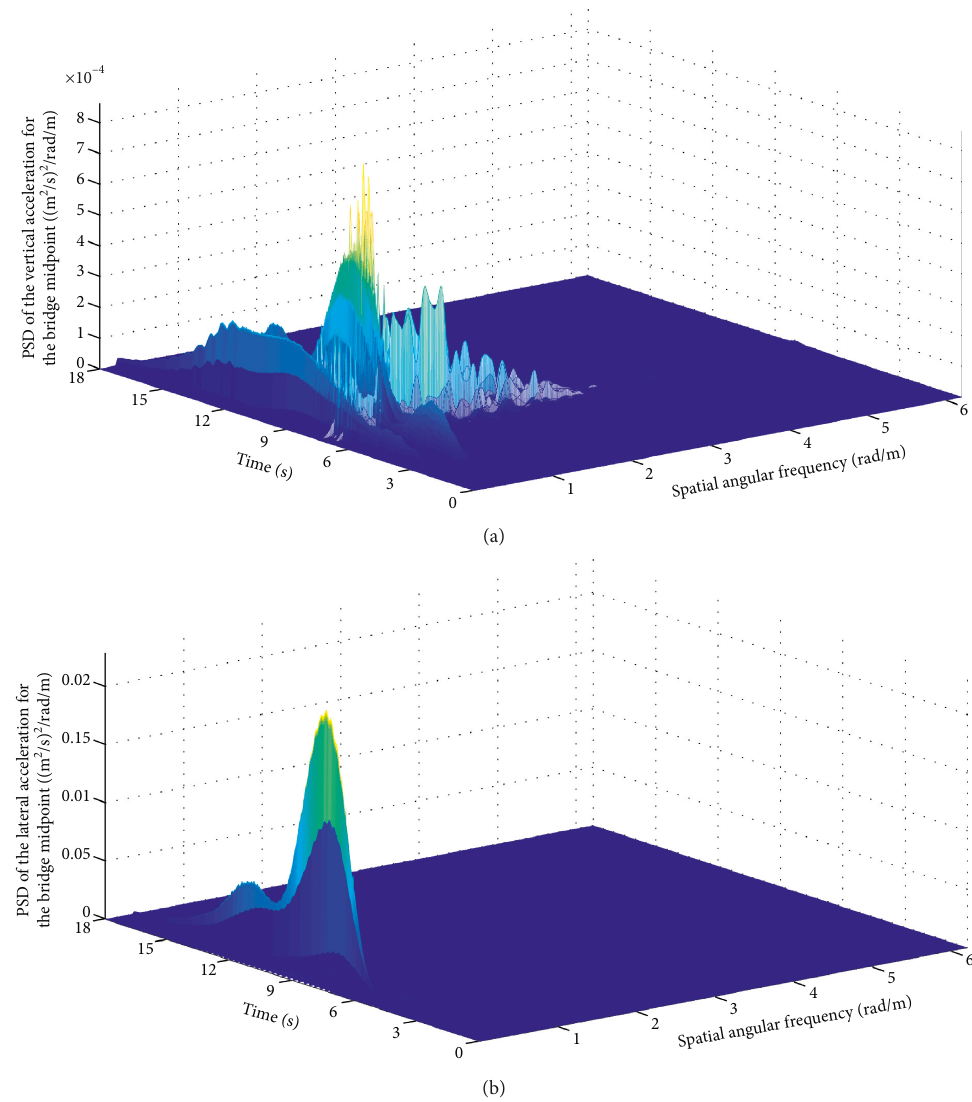
Figure 10: Time-dependent PSDs of the bridge midpoint acceleration for (a) vertical and (b) lateral